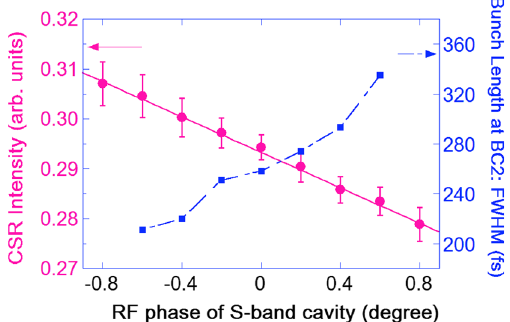
FIG. 35. Performance comparison between the CSRM and the RFDEF by using both of the observed bunch-length data. The dotted blue line with the solid squares indicates the bunch-length data (right vertical axis) taken by the RFDEF. The red solid line with solid circles expresses the intensity data of the CSRM signal (left vertical axis) from the pyrodetector at the BC2, which reflects the relative bunch length.